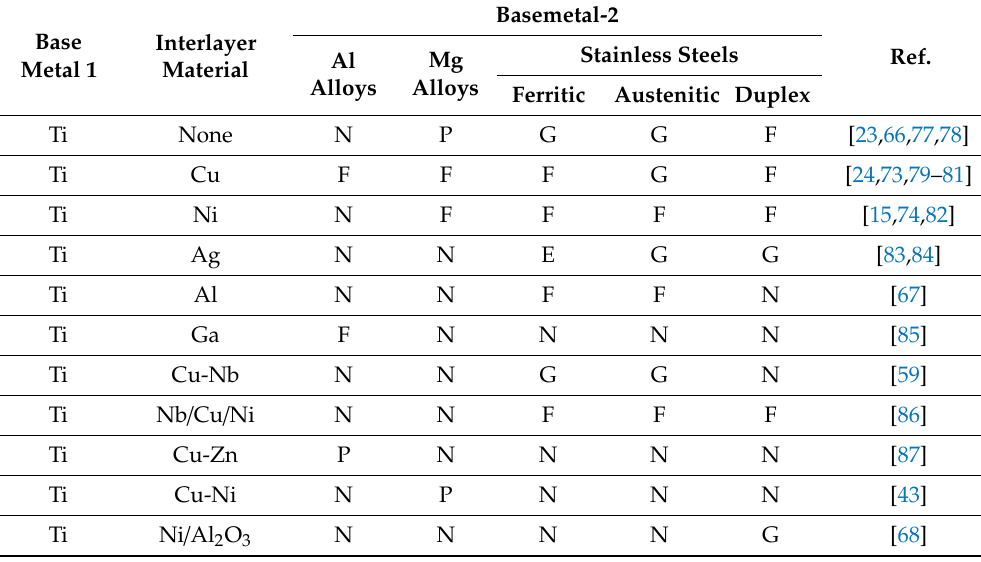
Table 3. Composition of interlayers used during di ff usion bonding Ti / Al, Ti / Mg and Ti / SS couples